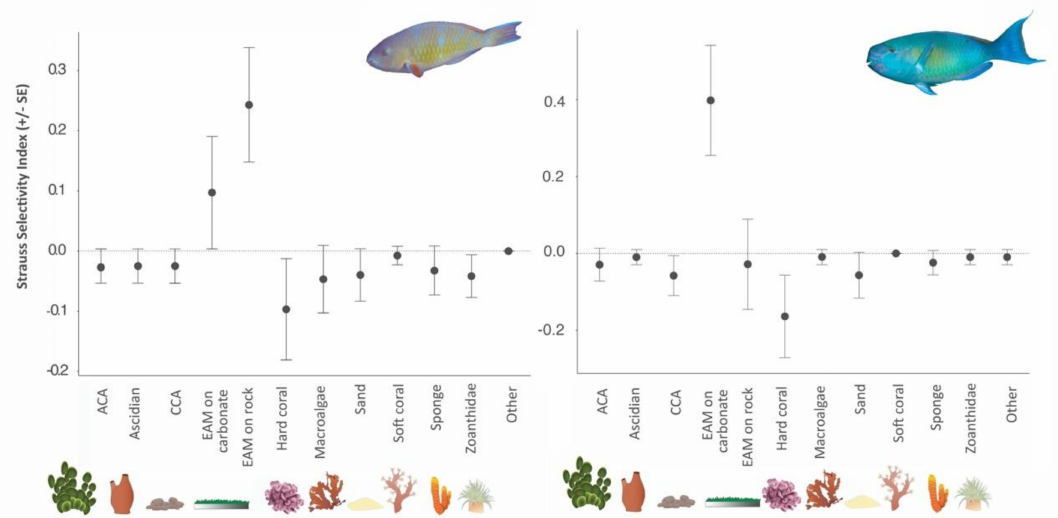
Figure 4. Strauss selectivity index plots showing food item preference for S. ghobban and S. rubroviolaceus on reefs. Positive values indicate preference and negative values avoidance of an item. Dots represent averages and bars standard error. Symbols courtesy of the Integration and Application Network, University of